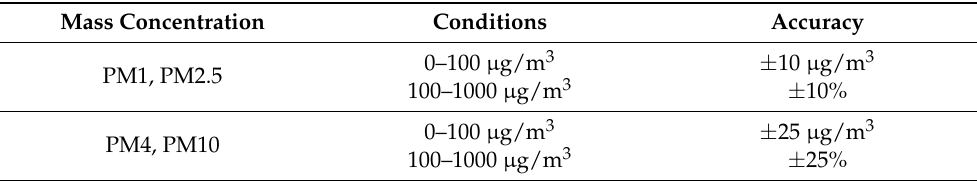
Table 1. Accuracy of SPS30 sensor.